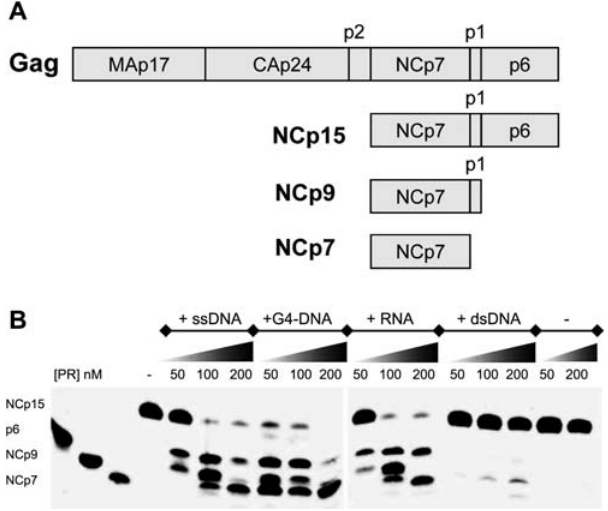
Figure 1. Proteolysis of NCp15 by PR. (A) Sequential and ordered proteolysis of the HIV-1 NC domain. Digestion of the Gag polyprotein The products shown were generated using three concentrations of recombinant PR (50, 100 and 200 nM) and incubated in the presence of a circular ssDNA (3,352 nt, 1.25 nM), a G4-DNA (250 nM), a 415-mer RNA fragment corresponding to the HIV-1 leader region (20 nM) or a 3,352 dsDNA plasmid (1 nM). Controls: p6, NCp9 and NCp7 are shown in the three far left lanes, whereas products of NCp15 incubation with two concentrations of PR (50 and 200 nM) in the absence of nucleic acid are shown to their